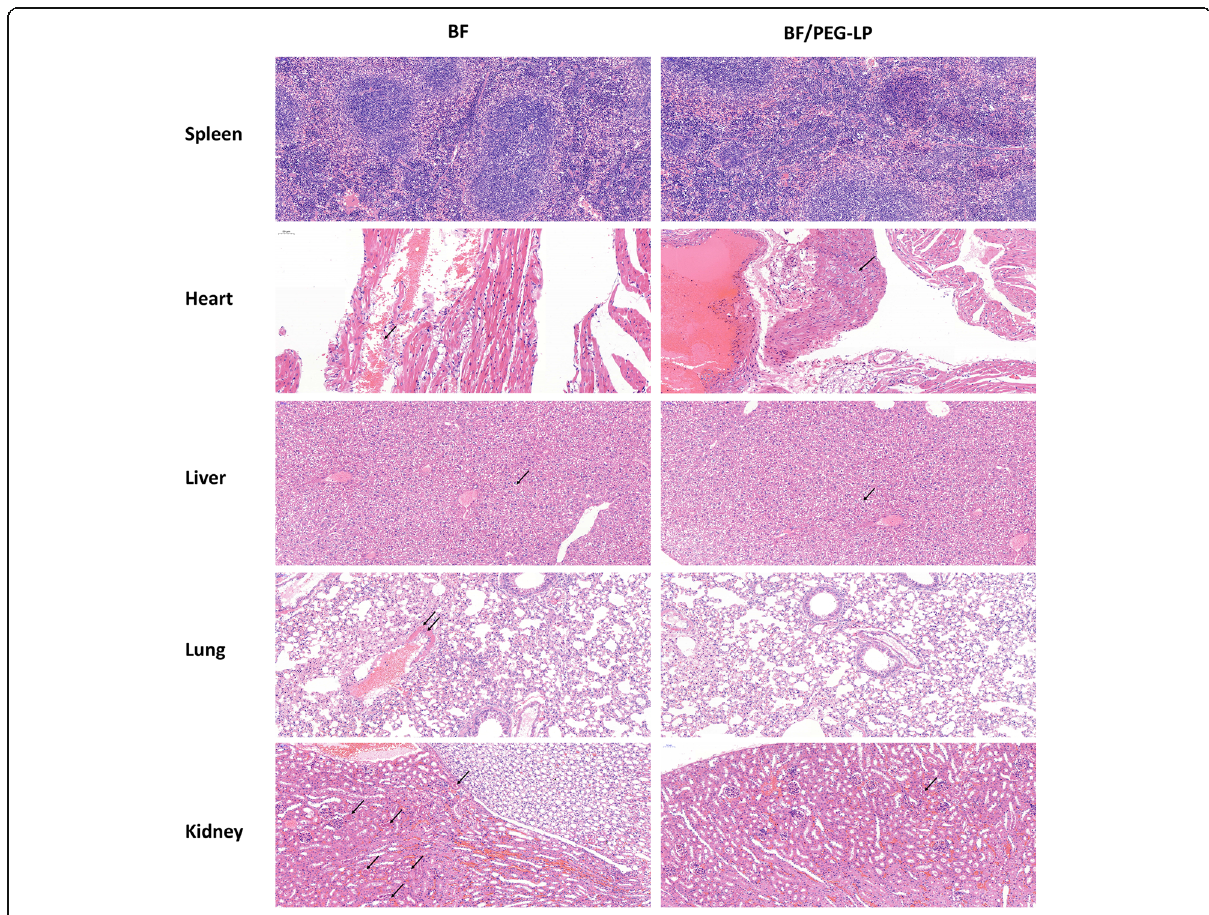
Fig. 5 Pathological changes observed in dead mice after intravenous administration of 1.0 mg/kg BF and 4.0 mg/kg BF/PEG-LP. Tissue sections